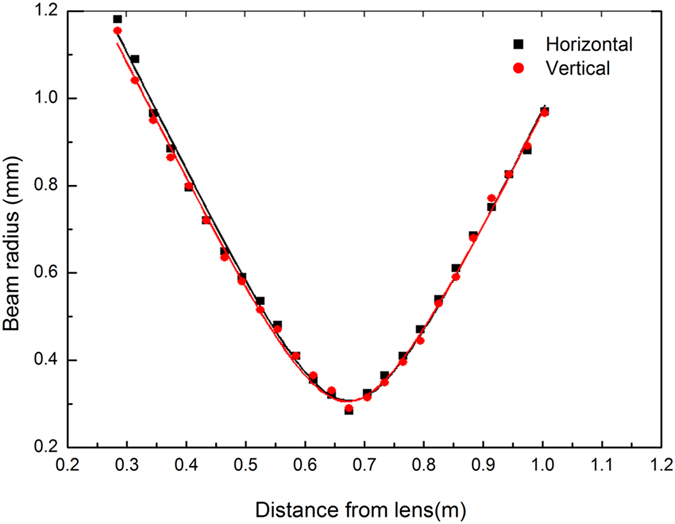
M2 beam quality for 1.1 W of pump power.